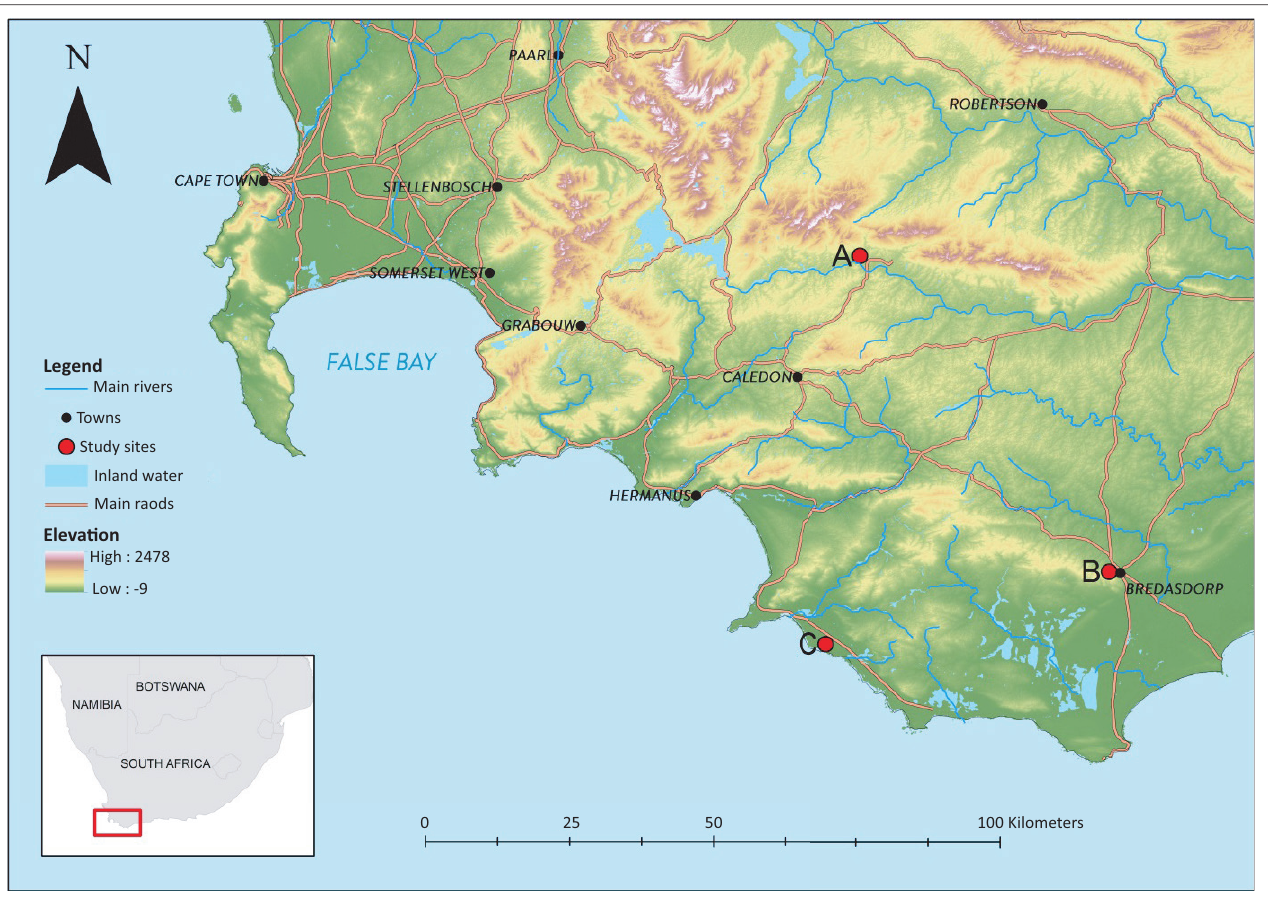
FIGURE 1: Study areas for investigating Cyclopia spp. phenology and their associated arthropod community were located within the Overberg district of the Western Cape, South Africa, in the vicinity of Genadendal (A), Bredasdorp (B) and Pearly Beach (C). TABLE 1: Study area descriptions of three sites where either wild or cultivated Cyclopia species grow, field sites in the Overberg, South Africa. Study area Cyclopia spp. (common